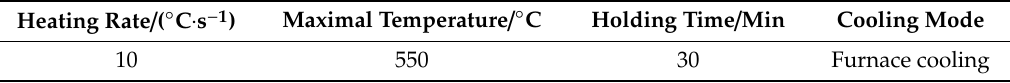
Table 1. Vacuum heat treatment